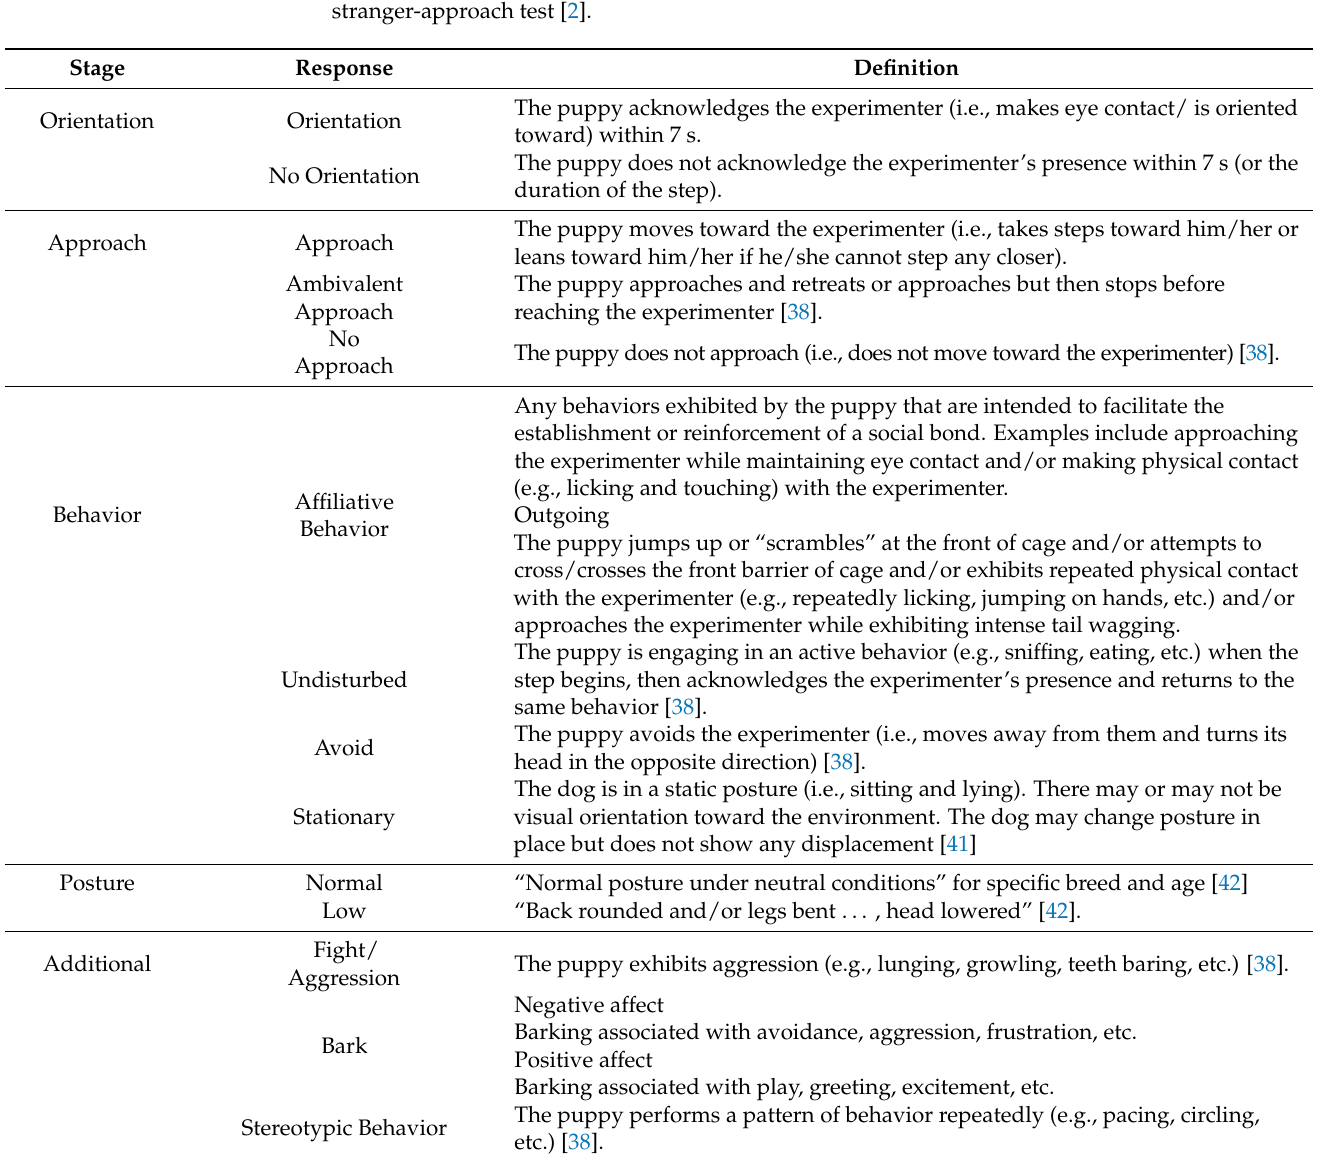
Table 2. Ethogram of puppy behaviors used to score their behavioral response to each step of the stranger-approach test